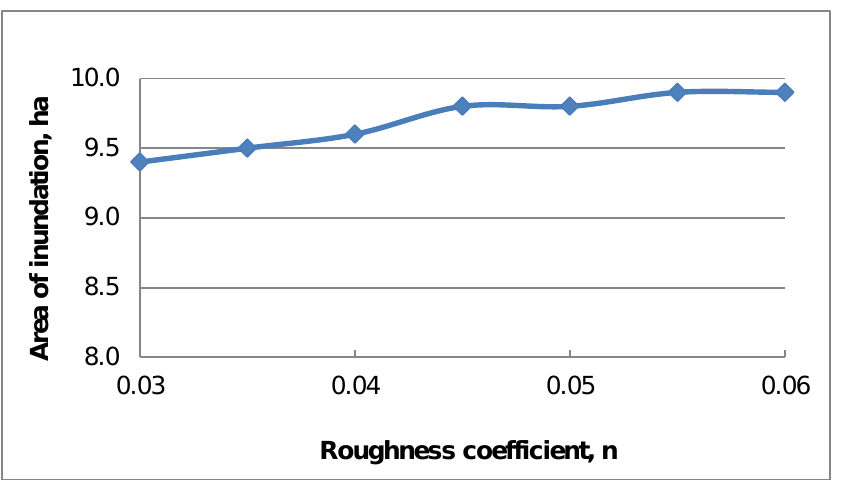
Figure 9. Sensitivity analysis of 1D channel roughness